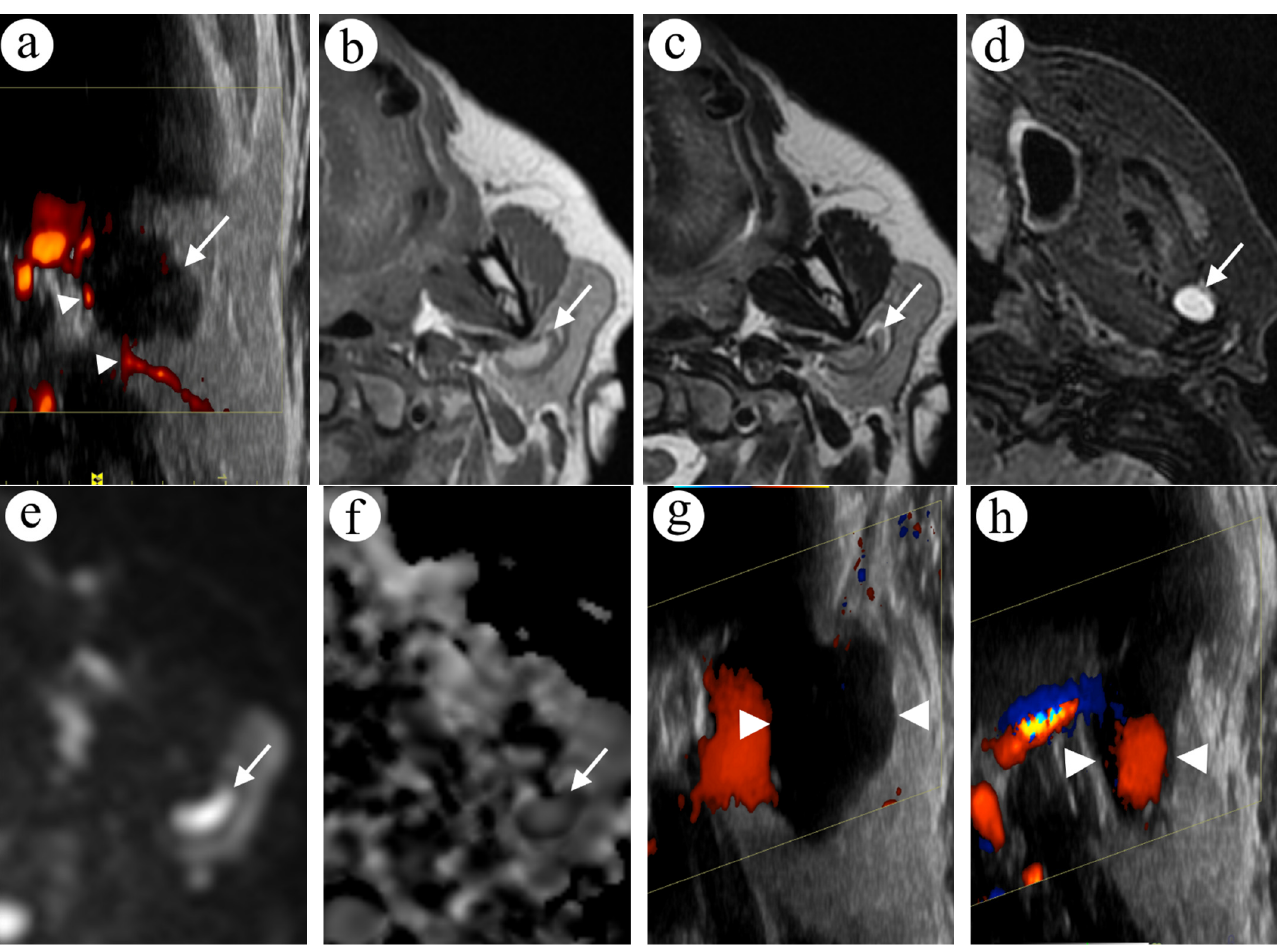
Figure 1. A focal lesion in the superficial lobe of the left parotid gland in US and MRI; all US images are rotated 90 degrees to match the anatomy in MR images. A polycyclic, hypoechoic and heterogenous lesion (arrow) is visible in US examination ( a ) with some vascular flow in the periphery of the lesion (arrowheads). In the turbo spin echo sequence in axial T1-weighted ( b ) and T2-weighted images ( c ), an ovoid lesion with a rim can be spotted (arrow). Additionally, in the fat-saturated short TI inversion recovery sequence in the axial T2-weighted image ( d ), a hyperintense lesion is adjacent to the left temporomandibular joint (arrow). In DWI ( e ) and the ADC map ( f ), the lesion shows diffusion restriction in the rim (arrow). In the follow-up US examination without ( g ) and with compression ( h ), the lesion is deformable (arrowheads).